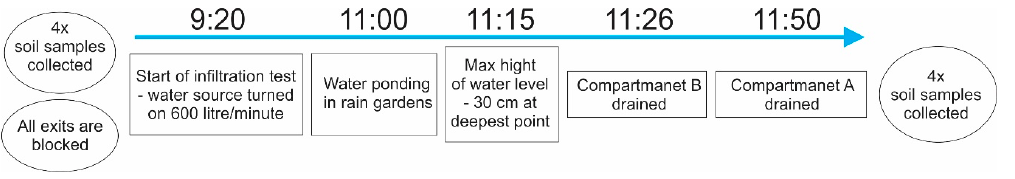
Figure 7. A fire hydrant served as a water source, providing ca. 600 L water per minute.